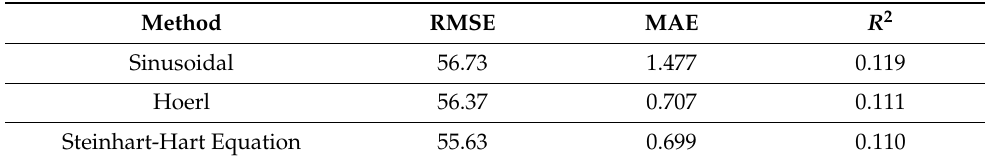
Table 6. Errors and correlations between observed and estimated annual precipitation amounts of the three selected non-linear regression methods.